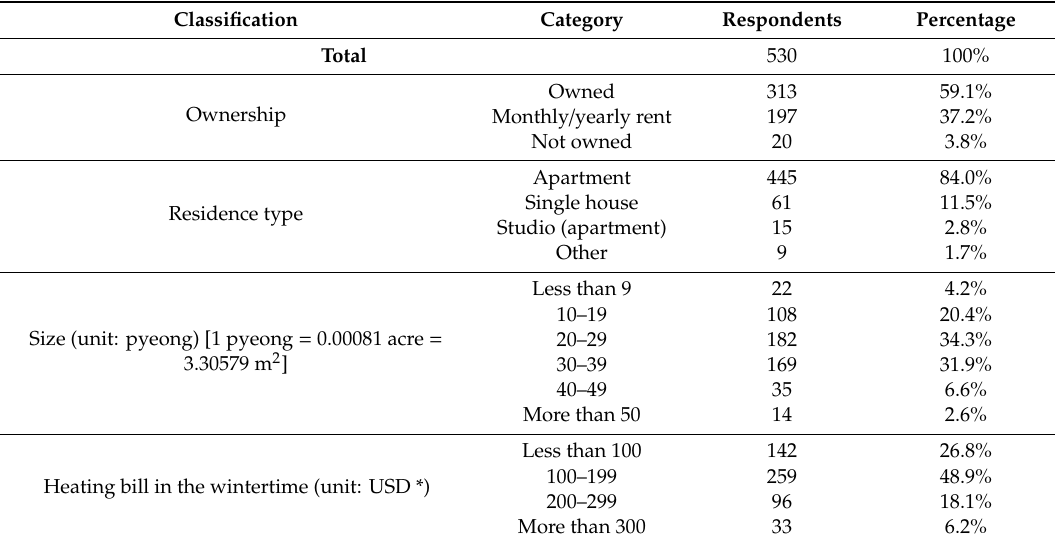
Table 4. Residence characteristics of the respondents.